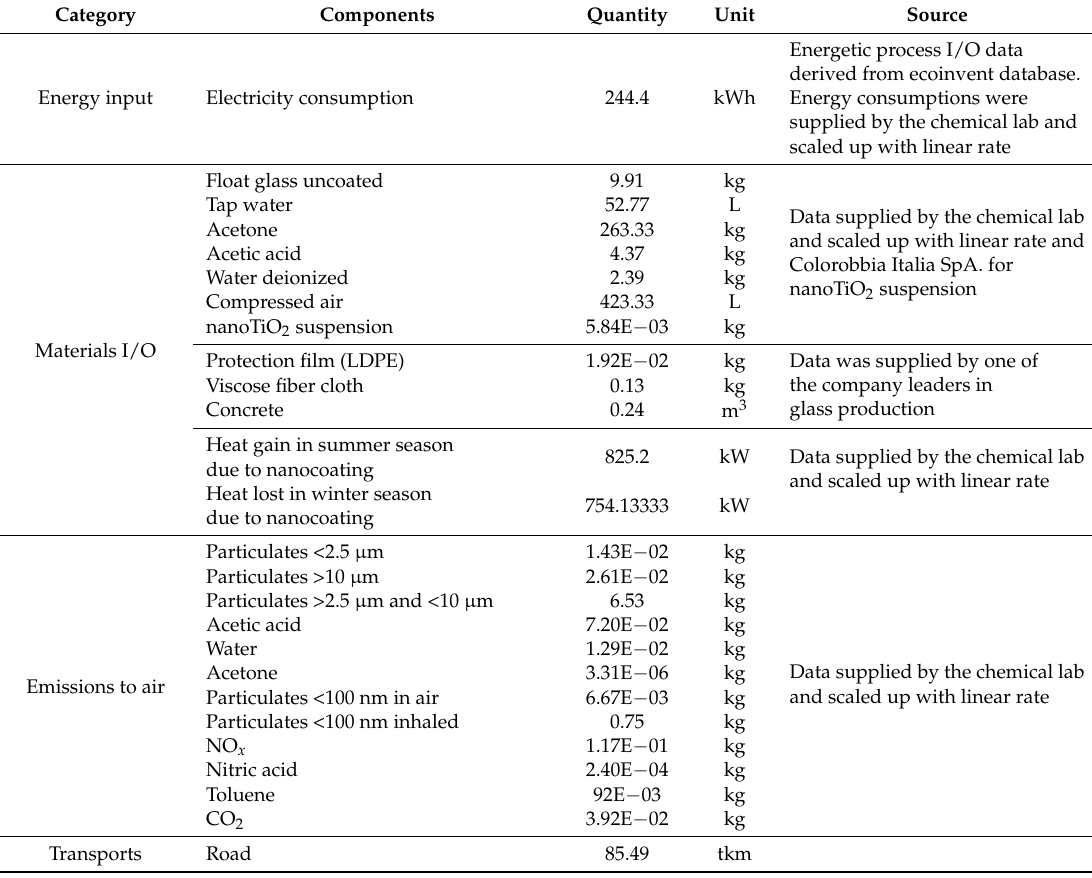
Table 1. Inventory data of 1 m 2 of nanoTiO 2 self-cleaning coated